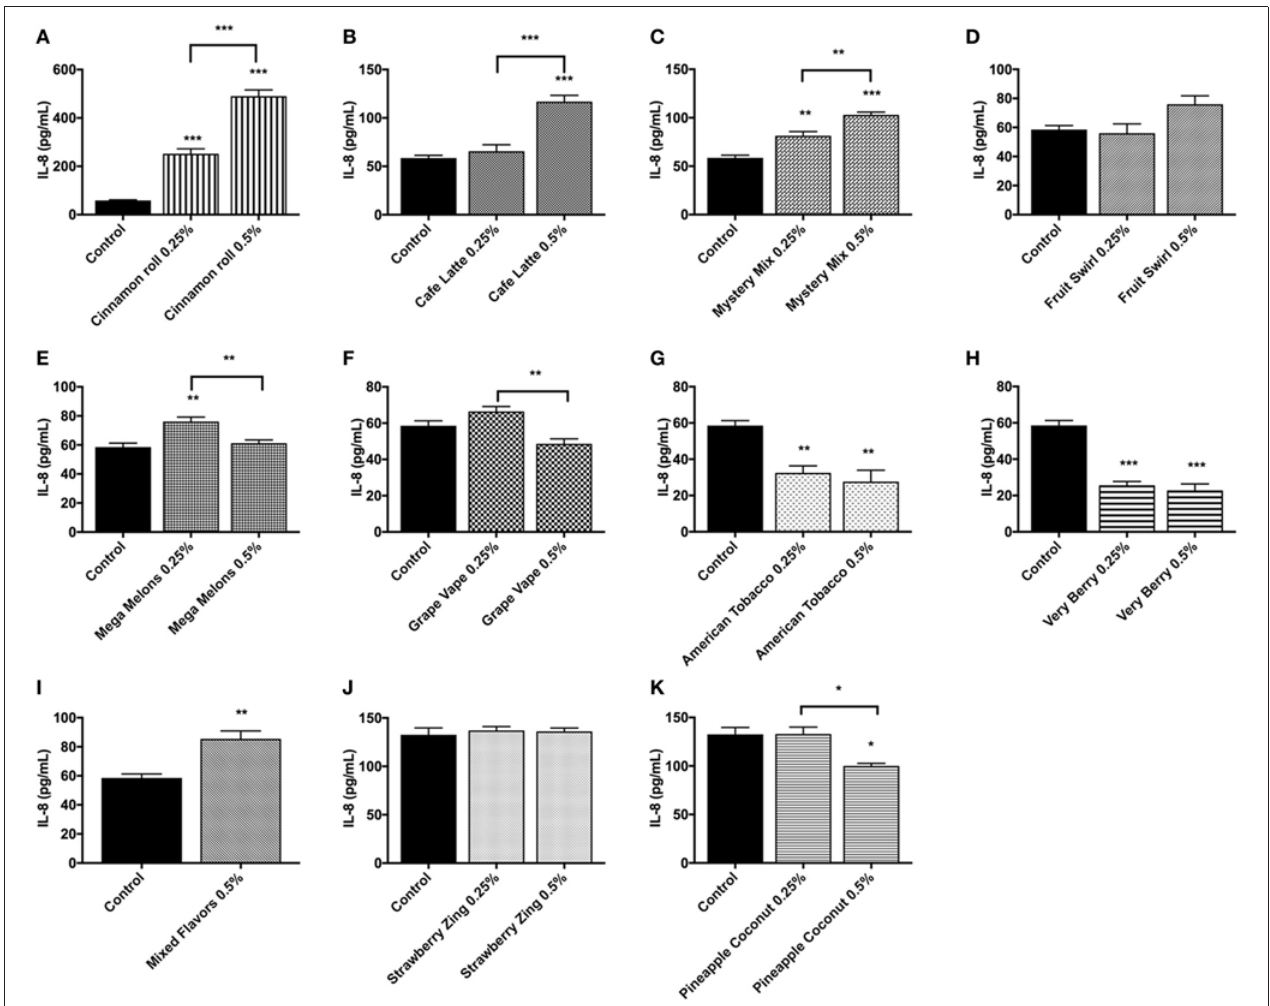
FIGURE 7 | E-liquids (A) Cinnamon Roll, (B) Café Latte, (C) Mystery Mix, (D) Fruit Swirl, (E) Mega Melons, (F) Grape Vape, (G) American Tobacco, (H) Very Berry, (I) Mixed Flavors, (J) Strawberry Zing, and (K) Pineapple Coconut induced pro-inflammatory cytokine, IL-8, response by U937 cells. U937 monocytes were treated with e-liquids at two doses, 0.25% and 0.5%, for 24h. Conditioned media was then assayed for IL-8 concentration by ELISA. Data are expressed as mean ± SEM. ( N = 4 per group. Statistical significance was determined by One-way ANOVA for multiple groups (Tukey’s comparisons test). * p < 0.05, ** p < 0.01, *** p < 0.001 vs. untreated control. Student t -test for comparing two groups (** p < 0.01 and *** p < 0.001 vs. untreated